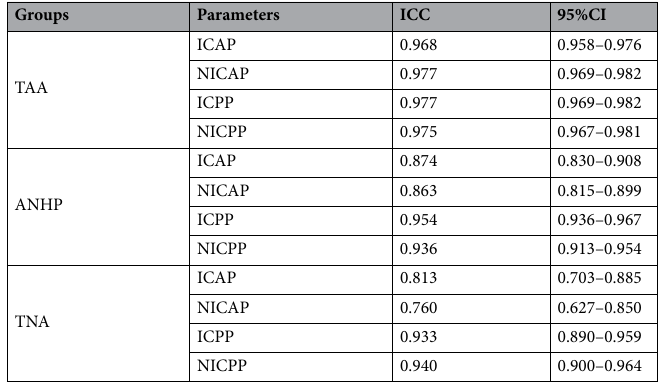
Table 3. ICC of the measurements between two radiologists. ICAP, iodine concentration at arterial phase; ICPP, iodine concentration at portal venous phase; NICAP, normalized iodine concentration at arterial phase; NICPP, normalized iodine concentration at portal venous phase; TAA, tumor active area; ANHP, adjacent normal hepatic parenchyma; TNA, tumor necrotic area.